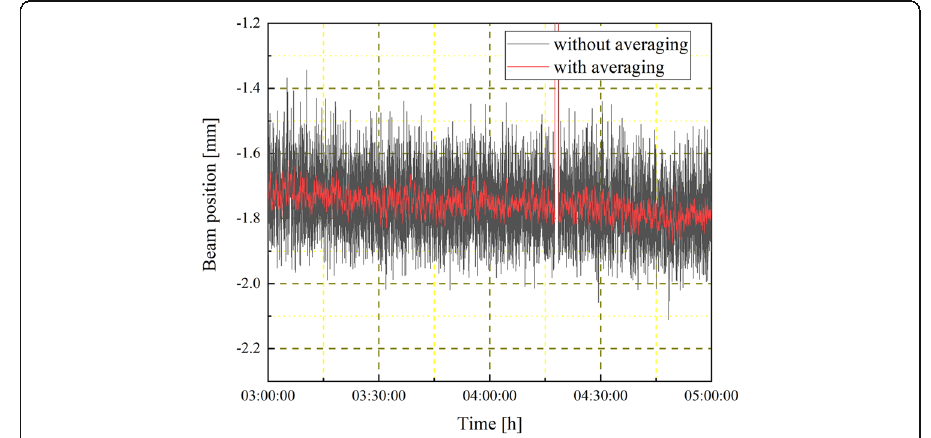
Fig. 6 Beam position data at L3BT with and without the application of moving